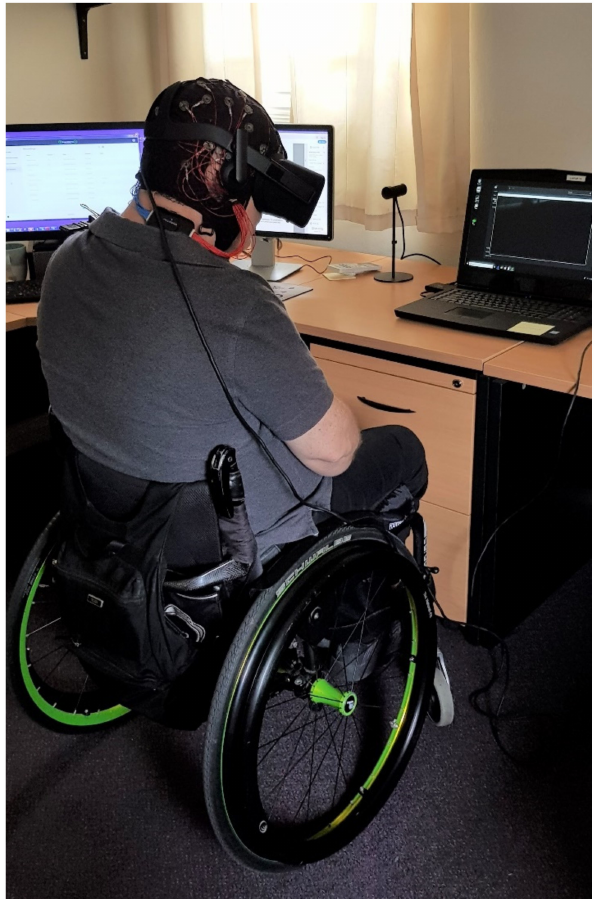
Figure 1. Participant with EEG and 3D HMD VR set